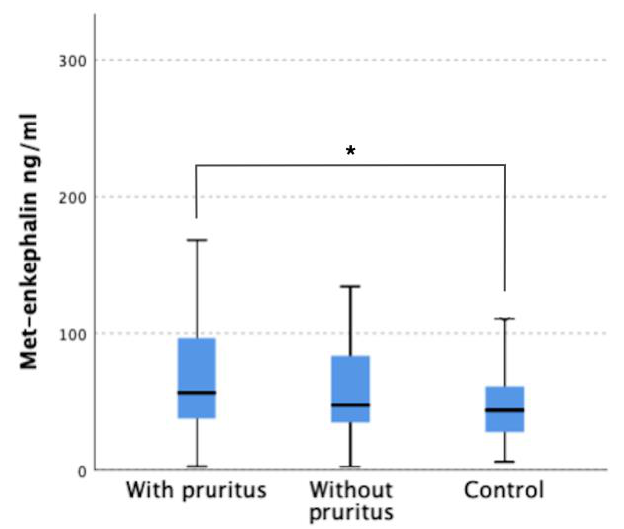
Figure 4. Serum level of Met-enkephalin in patients with pruritus, without pruritus, and control group. * p = 0.009.